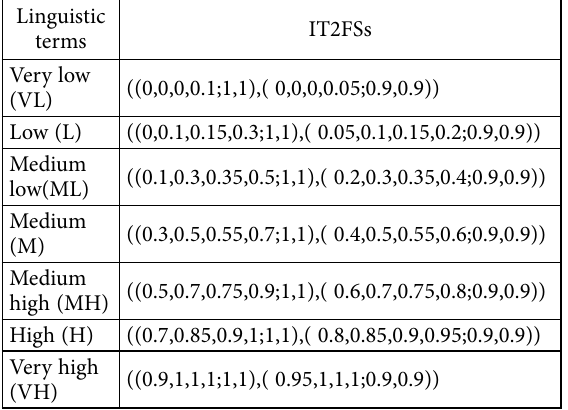
Table 1. Linguistic terms and their corresponding IT2FSs Linguistic terms